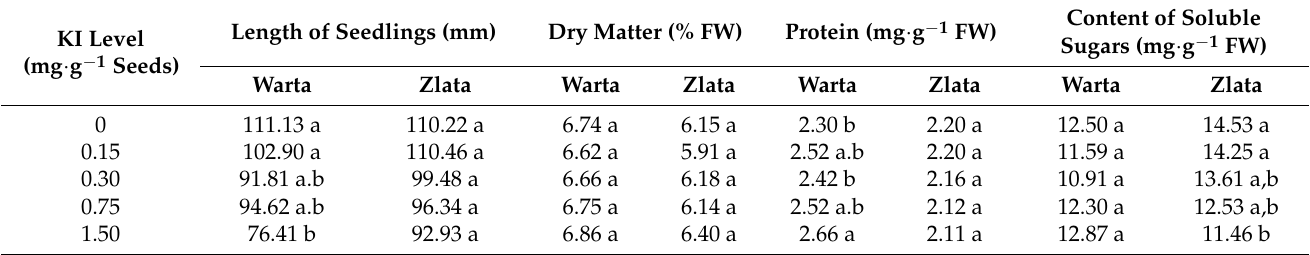
Table 2. Morphometric and biochemical characteristics of radish seedlings biofortified with iodine. KI